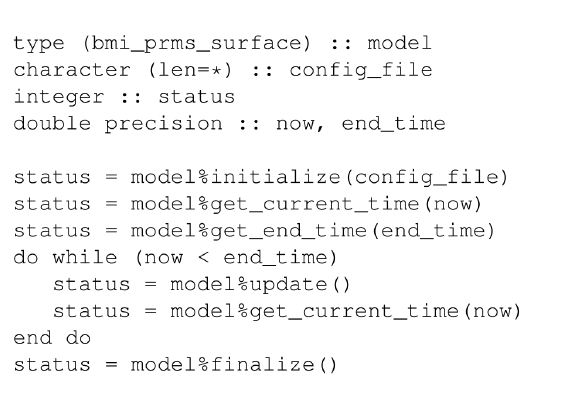
Listing 1. Example Fortran BMI